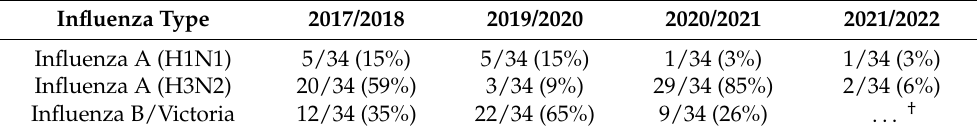
Table 4. Percentage of participants with hemagglutination inhibition titers ≥ 1:40.